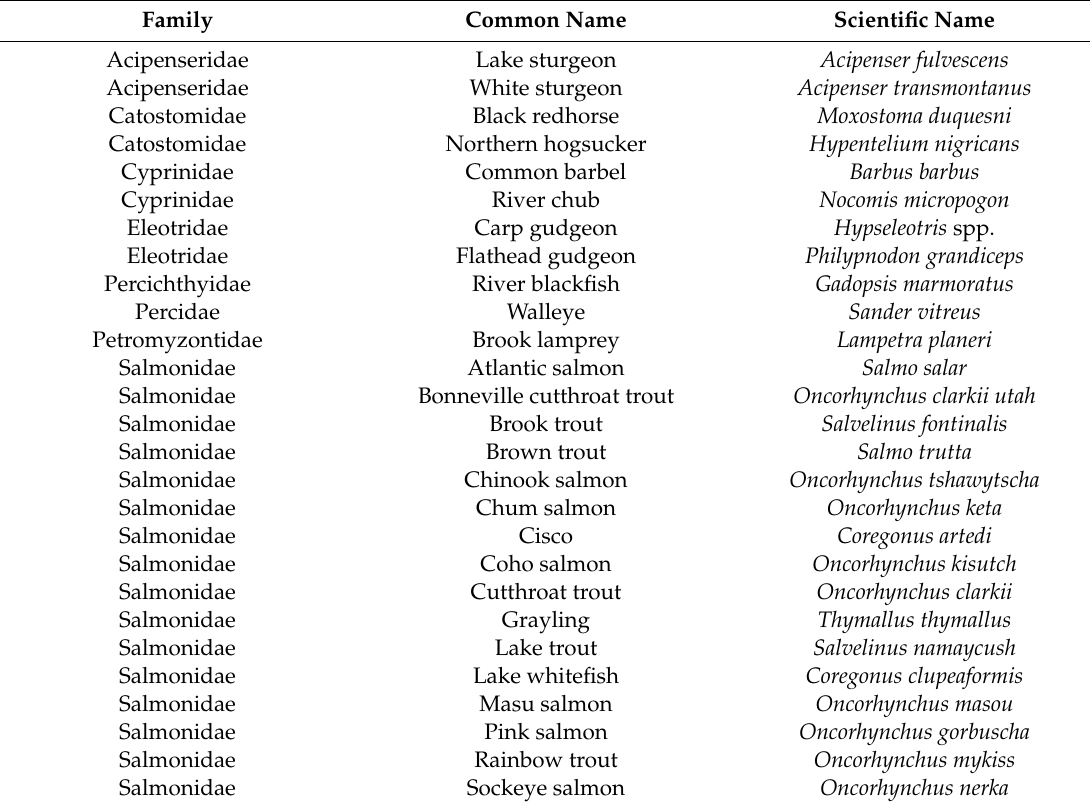
Table A1. Common and scientific names of fish taxa referenced in Table 1 of the main